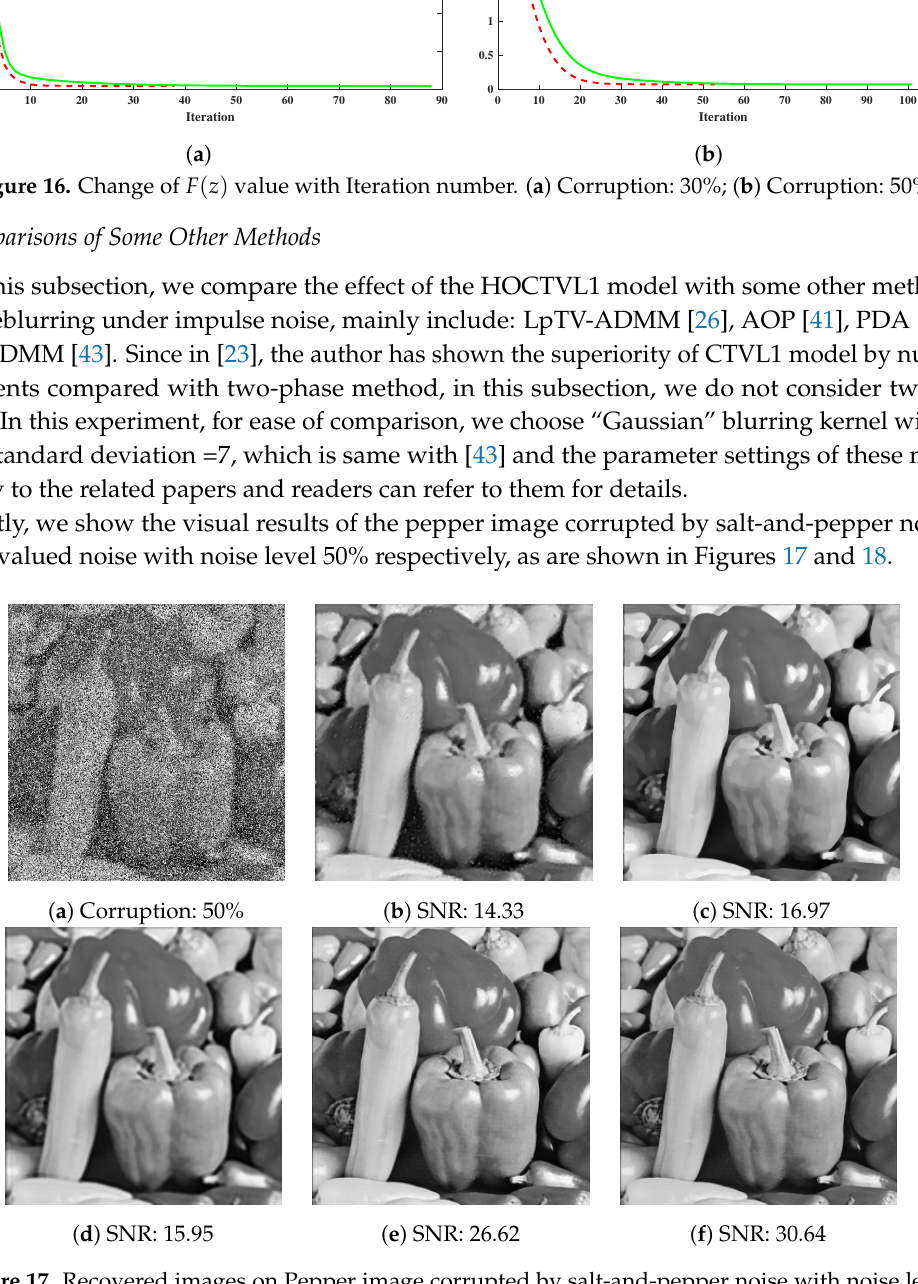
Figure 17. Recovered images on Pepper image corrupted by salt-and-pepper noise with noise level 50%. ( a ) Corrupted image. ( b ) Lp-ADMM. ( c ) AOP. ( d ) PDA. ( e ) L0TV-PADMM. ( f )